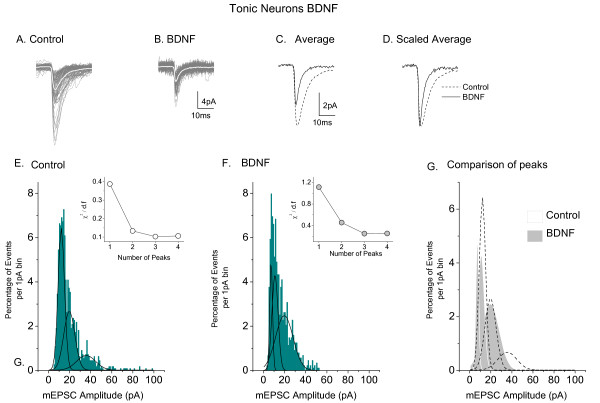
Analysis of the effects of BDNF on mEPSCs of tonic neurons (in vitro). A. Superimposed recordings of 3 min of mEPSC activity in a control tonic neuron, average of events presented as superimposed white trace. B. Similar superimposed recordings from a tonic neuron in a BDNF-treated culture. C. Averaged events from the neurons illustrated in A and B. D. Averaged events normalized to control size. Note marked increased rate of decay of current. E. Distribution histogram (1 pA bins) for amplitudes of 1100 mEPSCs from control tonic neurons. Fit of the data to three Gaussian distributions represented by black lines. F. Similar histogram and fit to three Gaussian functions for 877 mEPSCs from BDNF-treated neurons: Insets in E and F. Graphs to show effect of number of Gaussian fits (peaks) on the value of χ2 divided by the number of degrees of freedom. G: Superimposition of the three Gaussian peaks obtained in E with those obtained in F. Modified from reference [24] and reproduced with permission of the Physiological Society.